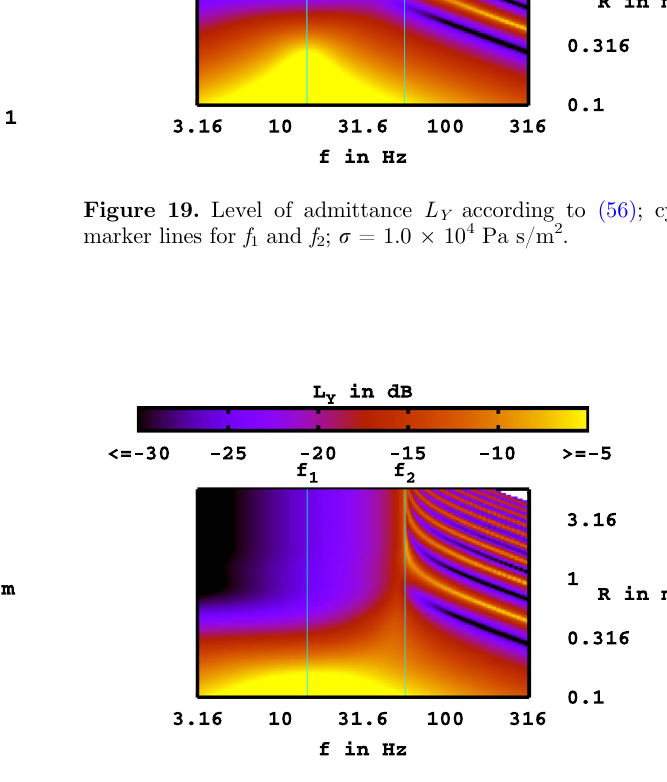
Figure 17. Level of admittance L Y according to (56); cyan marker lines for f 1 and f 2 ; r = 1.0 (cid:5) 10 2 Pa s/m 2 .